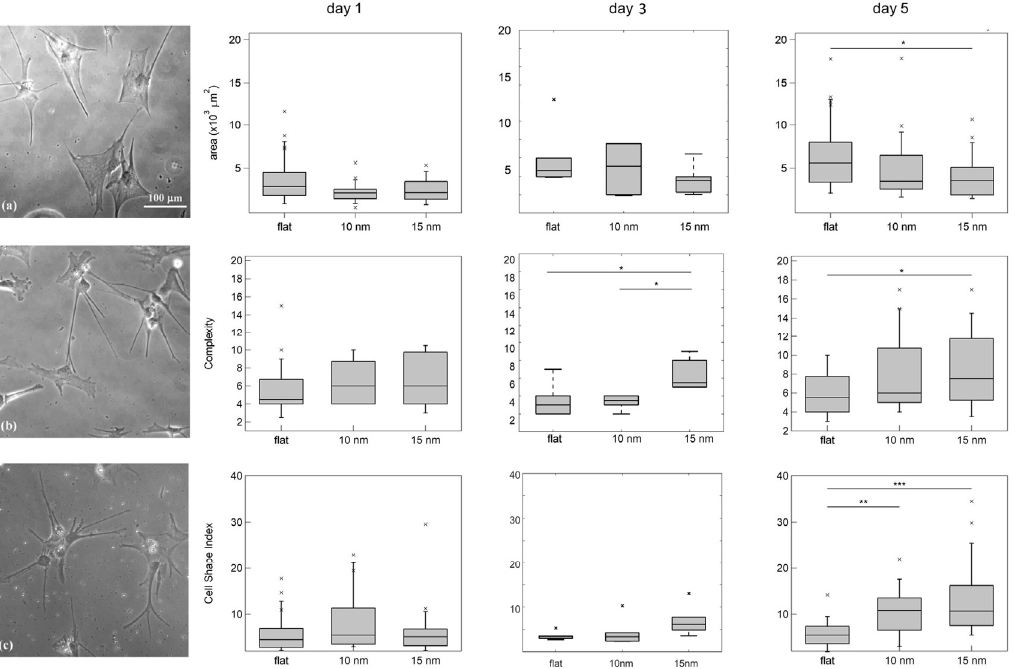
Figure 2. Optical images of astrocytes grown on flat zirconia ( a ), on 10-nm-rough zirconia ( b ) and on 15 nm of one ( c ) at 5 DIV. On the right are the morphological properties of astrocytes cultured on zirconia substrates with flat and nanorough (Rq = 10 nm or 15 nm) surface topography. The top boxplots display the cell area, the middle ones display the complexity parameter and the bottom ones display the CSI. The symbol * stands for outliers. All parameters are analysed after 1, 3 and 5